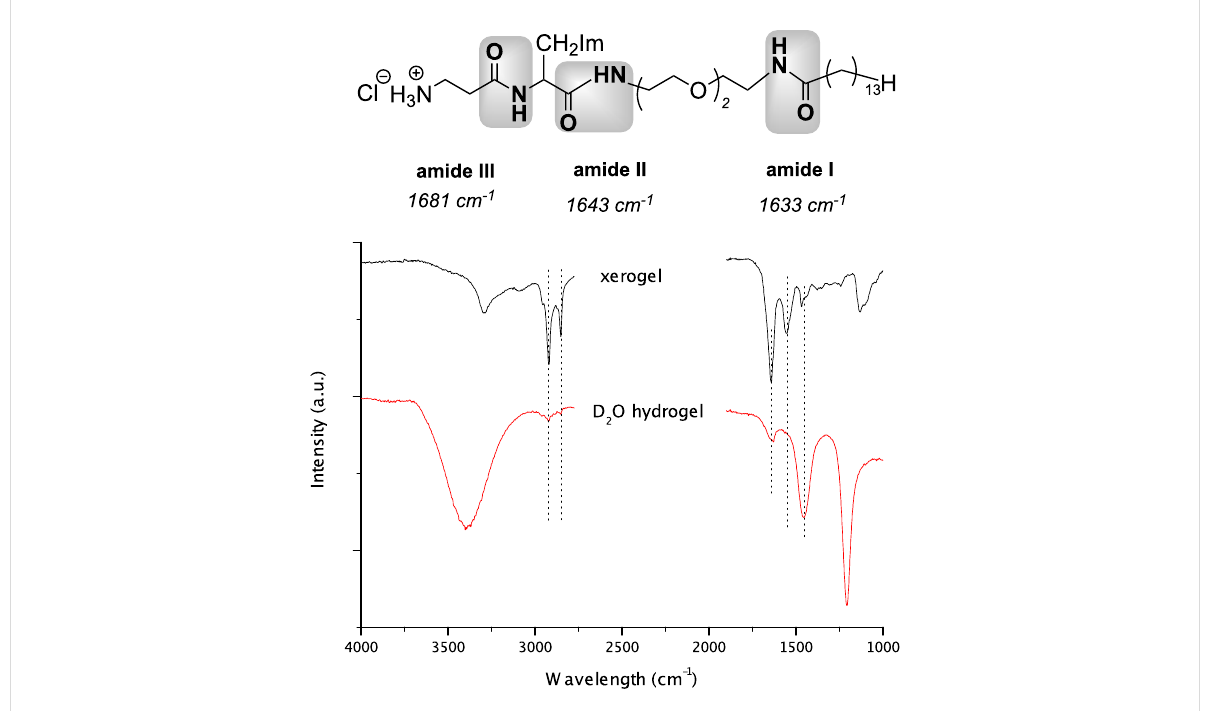
Figure 2: ATR spectra of β -Ala-His-EO 2 -C 14 in xerogel and D 2 O hydrogel,